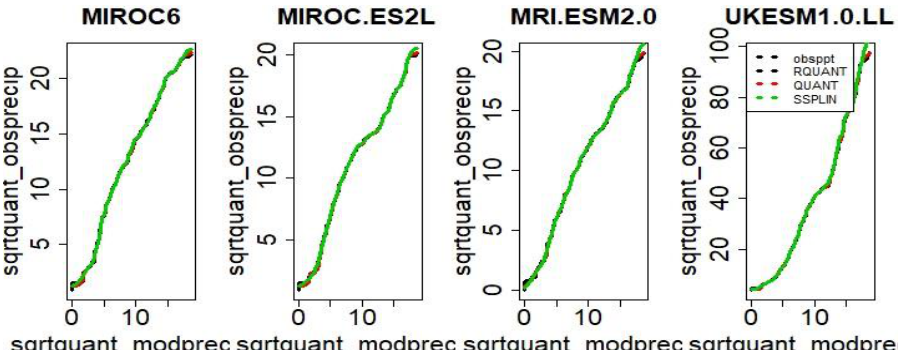
Figure A2. Square root quantile- quantile mapping of model precipitations ( CESM2 , CESM2-WACCM, FGOALS-g3, and MCM-UA-1.0f2) versus GPCC monthly observation precipitation.